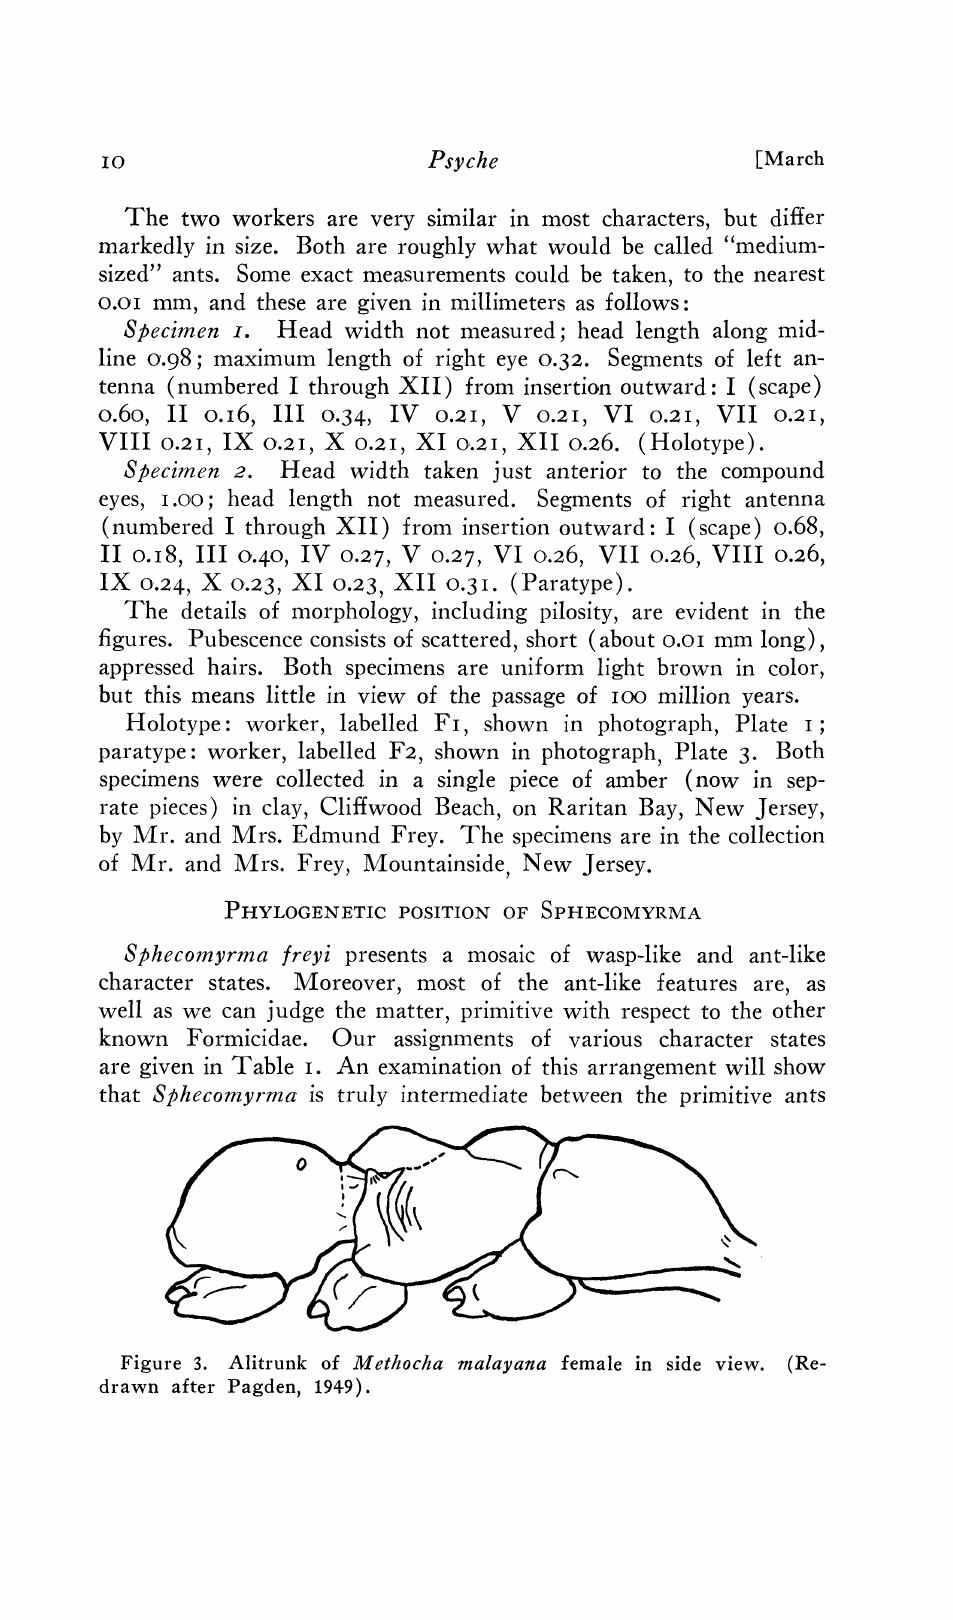
Figure 3. Alitrunk of Methocha malayana female in side view. (Re- drawn after Pagden,